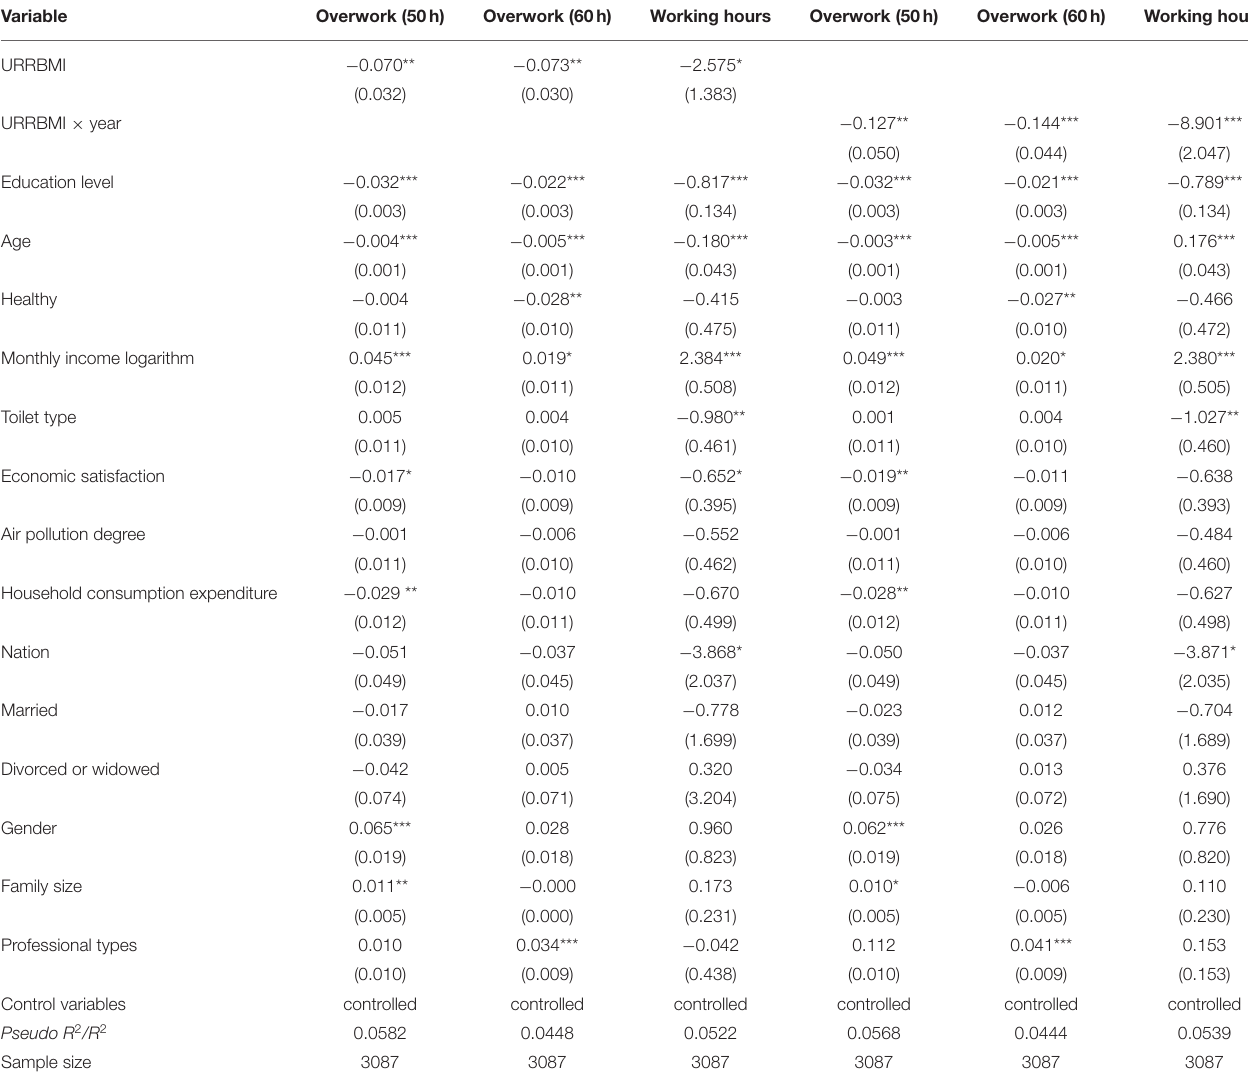
TABLE 3 | Benchmark